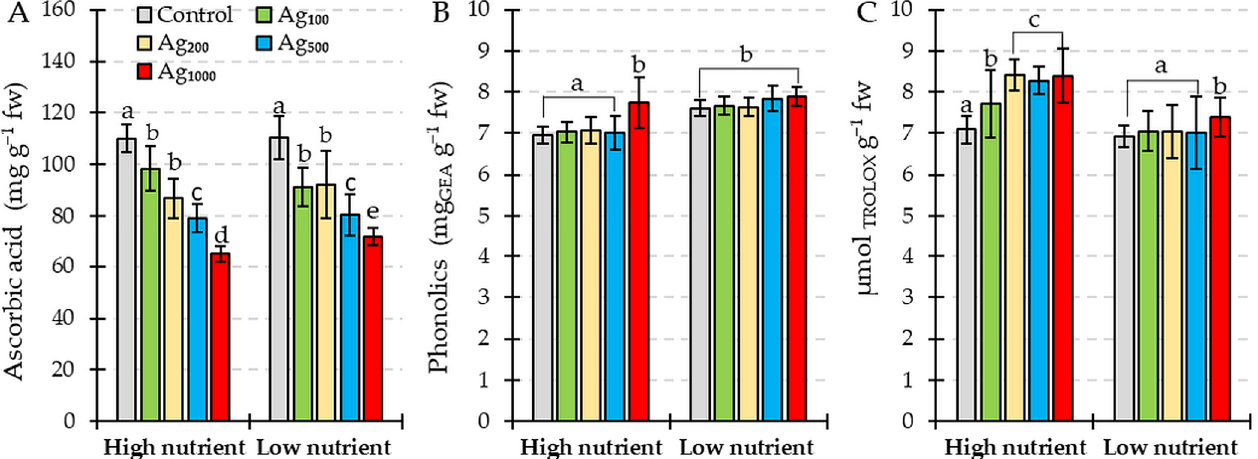
Figure 5. ( A ) Ascorbic acid, ( B ) total soluble phenolic compound concentration, and ( C ) free radical scavenging activity of L. gibba exposed to a two-hour pulse of different colloidal silver concentrations (control = 0 µg/L; Ag ₁₀₀ = 100 µg/L; Ag ₂₀₀ = 200 µg/L; Ag ₅₀₀ = 500 µg/L; Ag ₁₀₀₀ = 1000 µg/L) combined with two levels of total nitrogen and total phosphorus nutrition (high nutrients; low nutrients). Values shown are mean ± standard deviation of ten replicates ( n = 10). Di ff erent le tt ers indicate signi fi cantly di ff erent values (HSD, p < 0.05).